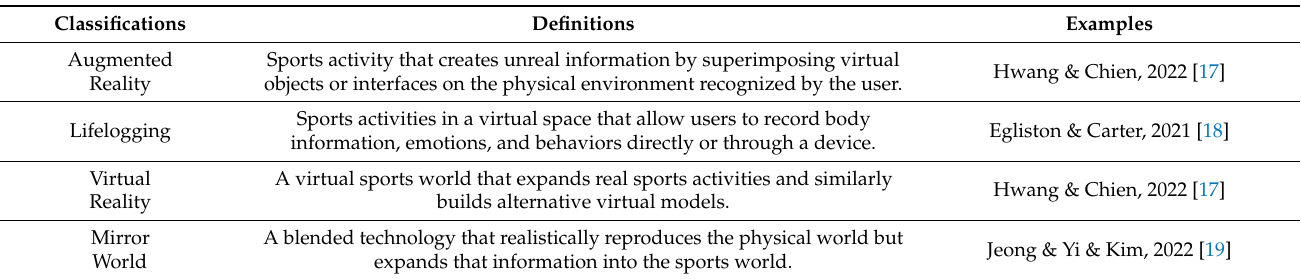
Table 2. The functions, necessary tools, and examples according to four metaverse